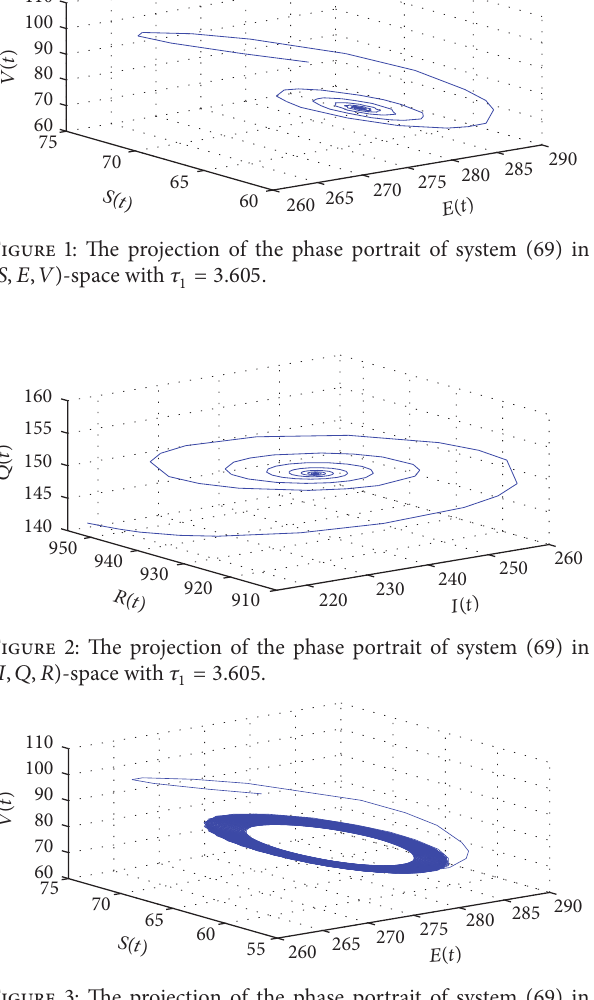
Figure 6: The projection of the phase portrait of system (69) in (𝐼, 𝑄, 𝑅) -space with 𝜏 = 3.65 . 2